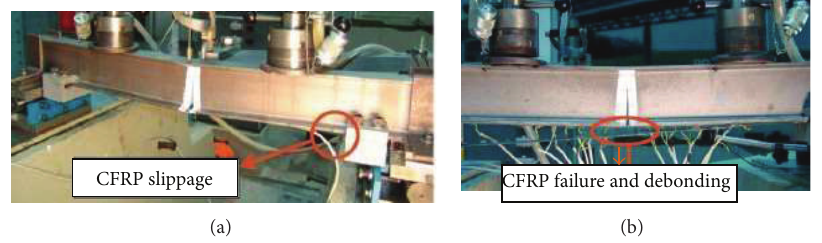
Figure 13: The failure modes for (a) PUR technique and (b) PBR technique.